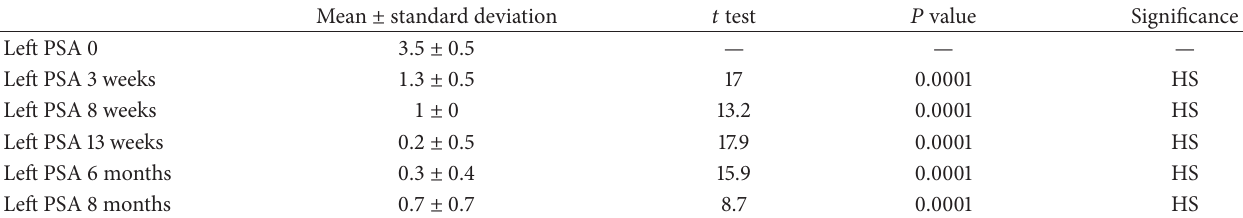
Table 2: Comparison between palm sweating area (PSA) score before treatment and at follow-up visits in the left palm (Dysport). Mean ± standard